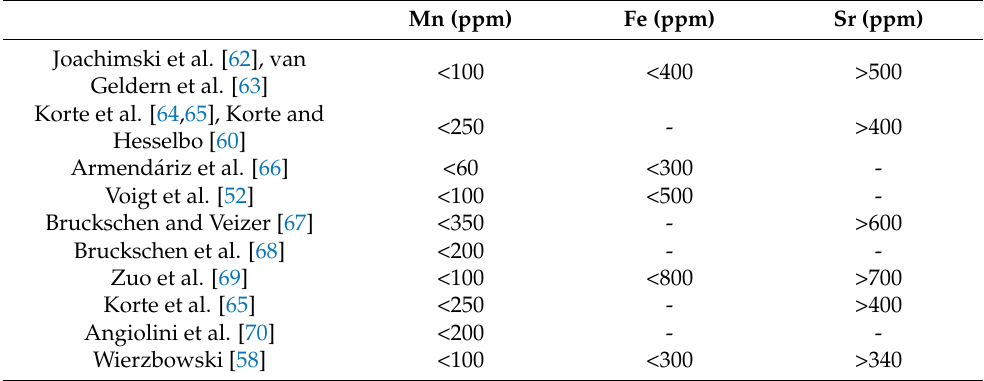
Table 2. Published threshold limits of element concentrations in well-preserved brachiopod shells.